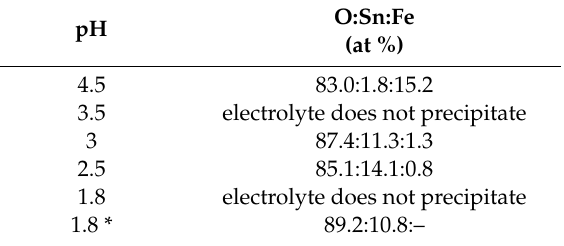
Table 3. Stoichiometry of the precipitates isolated after approximately 3 h of the electrolyte